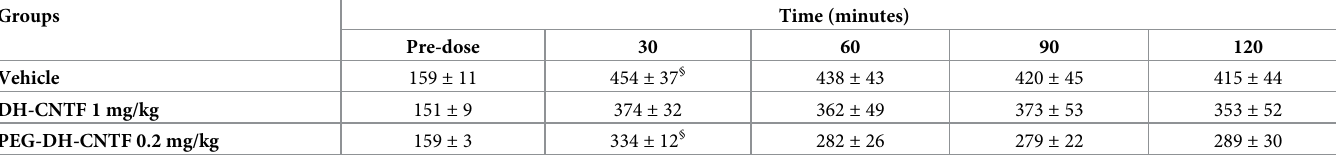
Table 4. IPGTT data in DIO mice. Starting Blood glucose levels in DIO mice were determined after 6 h fasting. Groups